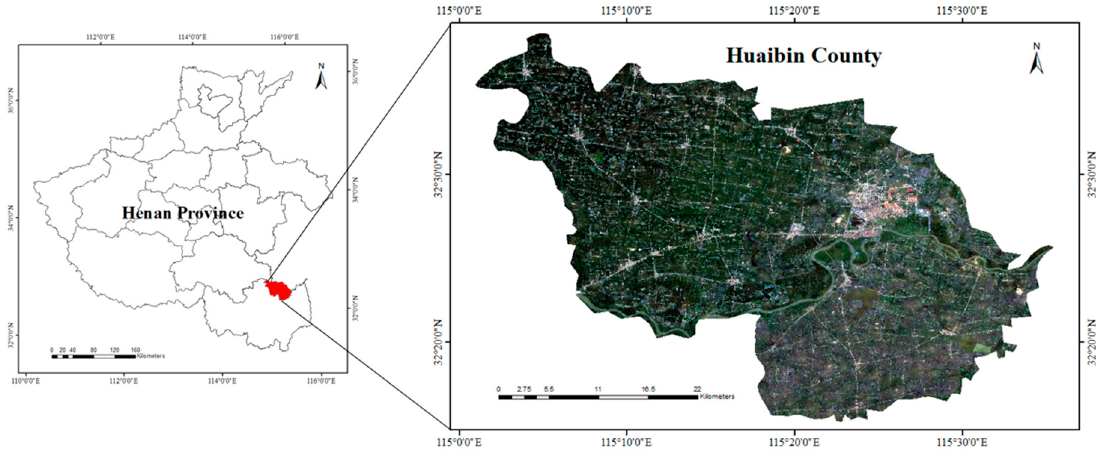
Figure 1. Location of Huaibin County, Henan Province, China.